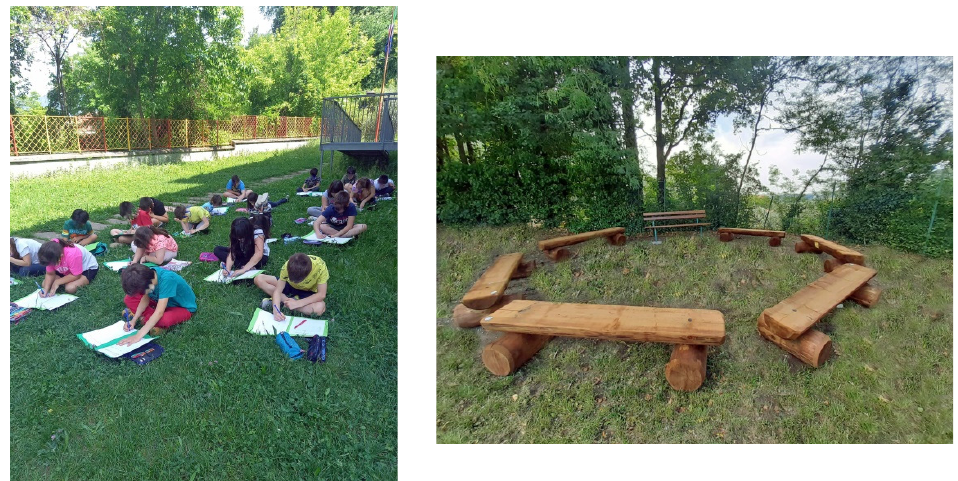
Figure 1. The natural environment of the two schools.